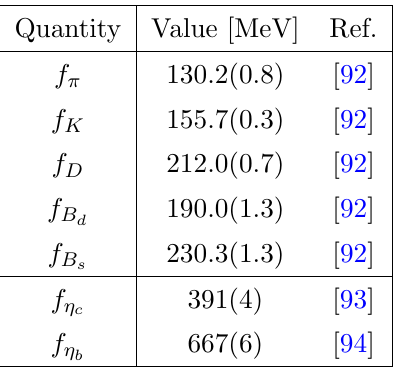
Table 2 . Decay constants computed by means of numerical simulations of QCD on the lattice. Pseudoscalar quarkonia